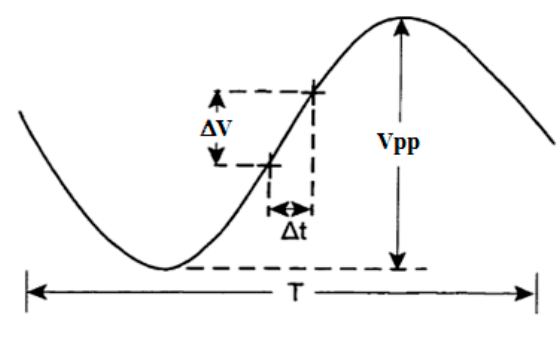
Figure 5. Effect of the sampling jitter.